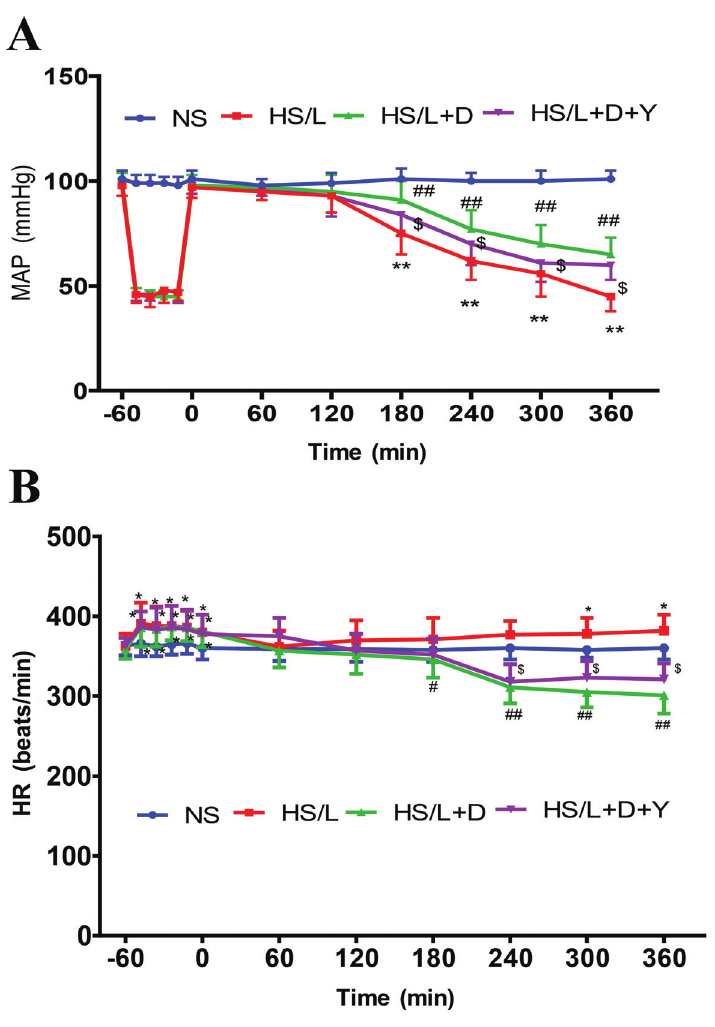
Figure 1. Changes in mean arterial pressure (MAP) ( A ) and heart rate (HR) ( B ) from the NS control (normal saline), hemorrhage/resuscitation plus lipopolysaccharide (HS/L), HS/L plus dex- medetomidine (HS/L + D), and HS/L + D plus yohimbine (HS/L + D + Y) groups. Data are reported as means ± SD. **P o 0.01, *P o 0.05 vs the NS group; ## P o 0.01, # P o 0.05 vs the HS/L group; $ P o 0.05 vs the HS/L + D group (ANOVA).